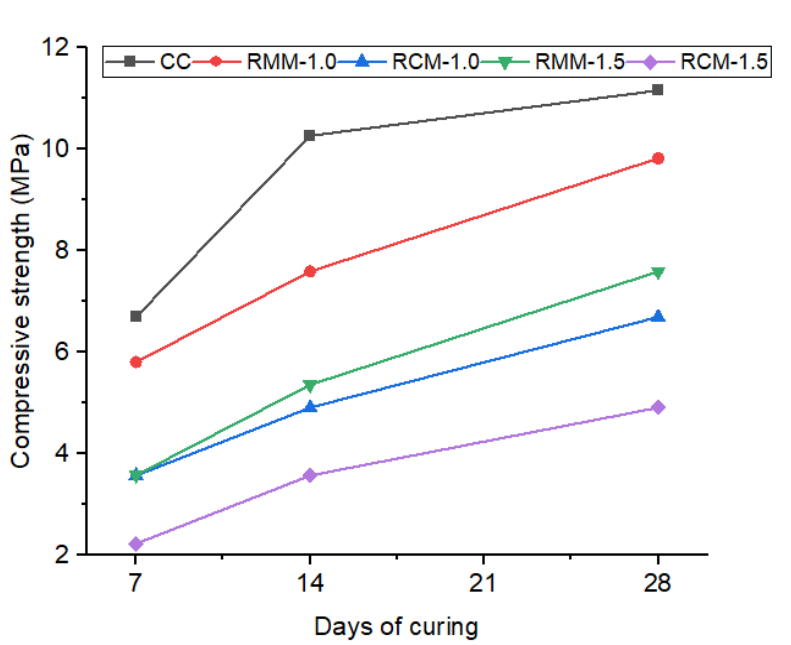
Figure 5. Compressive strength test results.